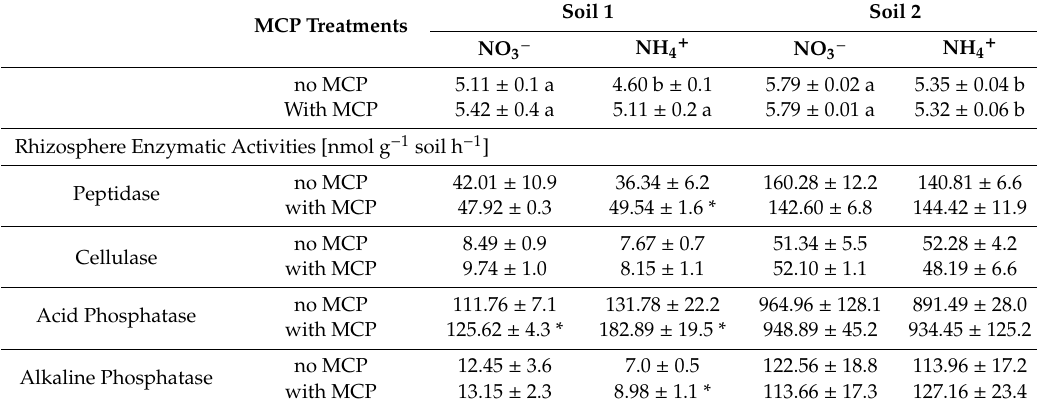
Table 2. Rhizosphere pH and rhizosphere-enzymatic activities of cellulase, peptidase and phosphatases as a ff ected by MCP inoculation on soil 1 (sandy-loam, pH 6.1 P CAL 7 mg kg − 1 soil) and soil 2 (clay-loam, pH 5.9, P CAL 20 mg kg − 1 soil) receiving N fertilization in form of Ca-nitrate (NO 3 − ) or